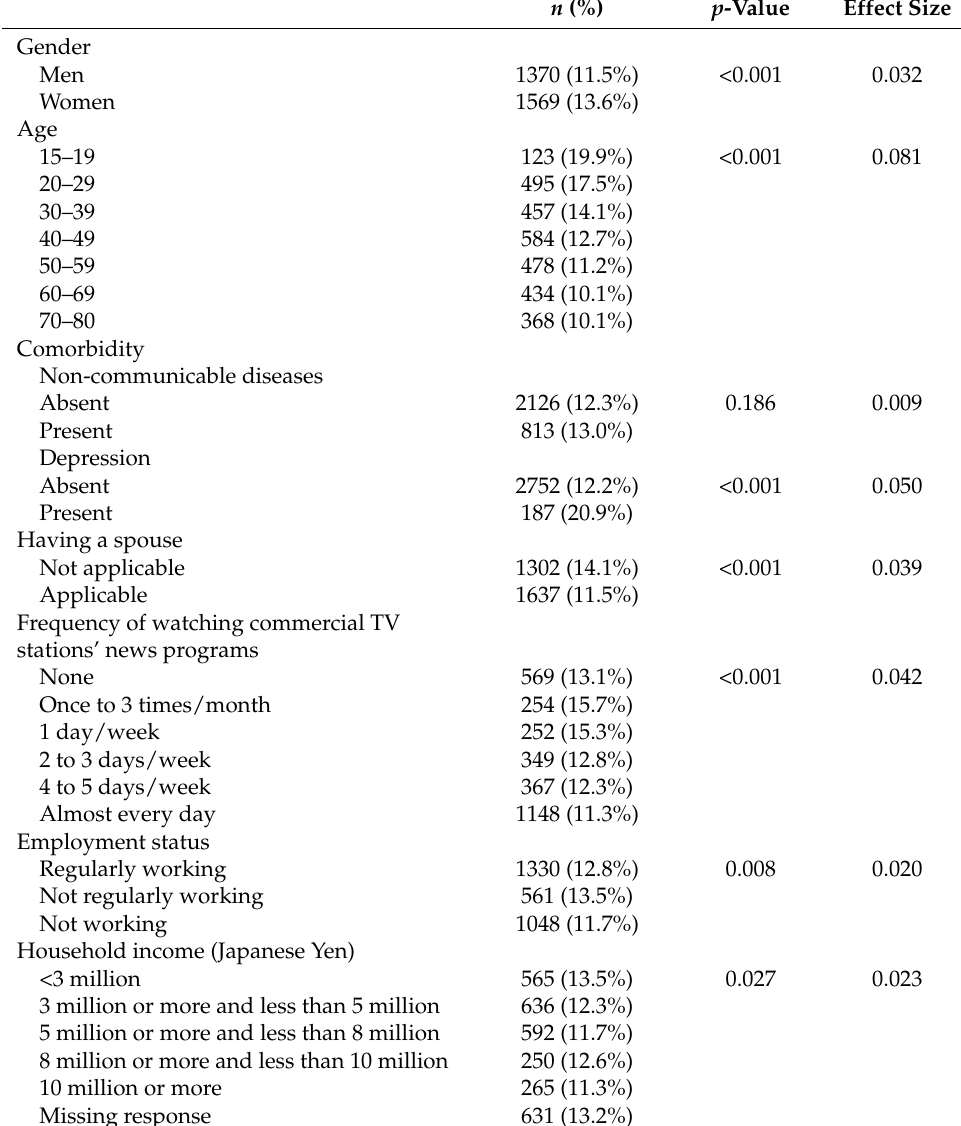
Table 6. Proportions of perceived susceptibility to